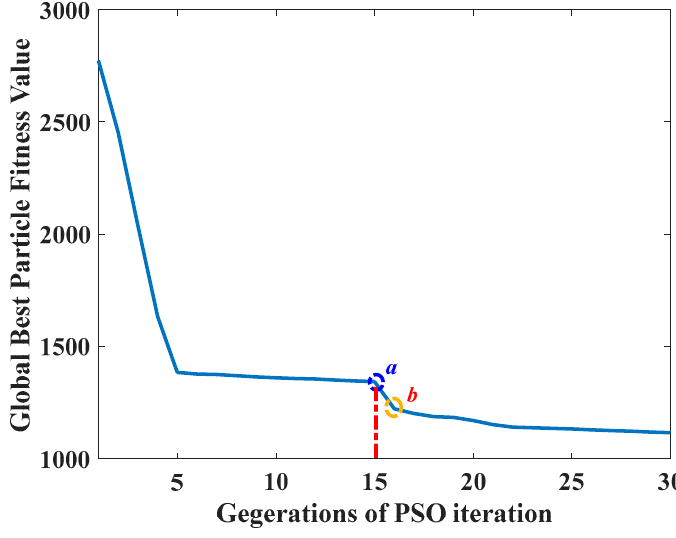
Figure 18. Fitness values of controller A.